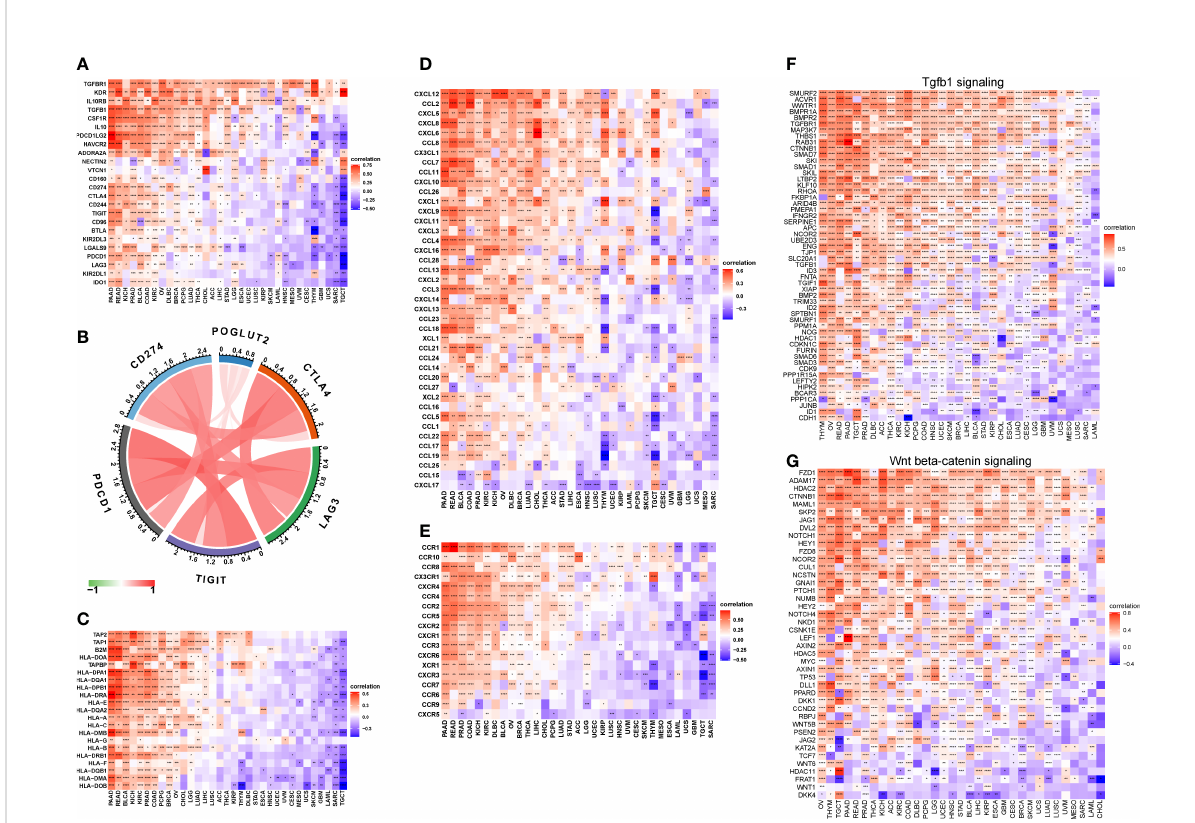
FIGURE 6 The association between POGLUT2 and immune-related genes. (A) The association between POGLUT2 and immune inhibitory genes in pan- cancer. (B) The association between POGLUT2 and immune checkpoint genes in breast cancers. (C) The association between POGLUT2 and MHC genes. (D) The association between POGLUT2 and chemokines. (E) The association between POGLUT2 and chemokine receptors. (F) The association between POGLUT2 and immune inhibitory genes in pan-cancer in speci fi c signaling pathways. Left, TGF-beta1 signaling. Right, Wnt- beta-catenin signaling. (G) the top 3 POGLUT2 positively correlated genes were